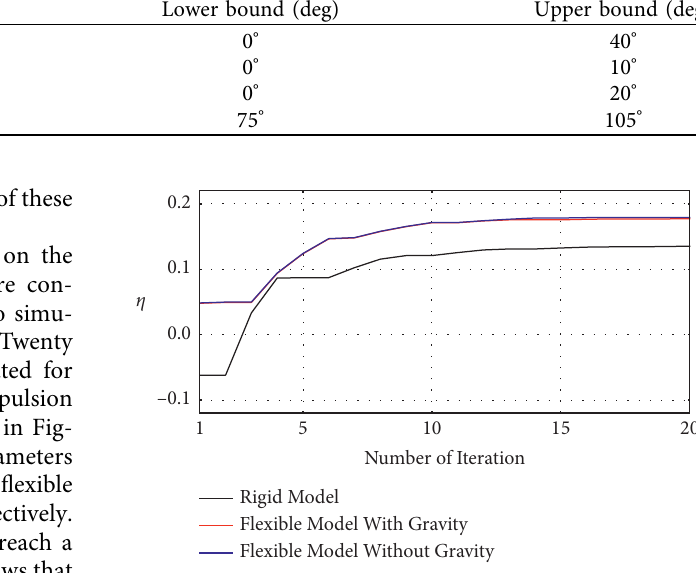
Figure 9: Maximum propulsion efficiency vs. the number of the optimization